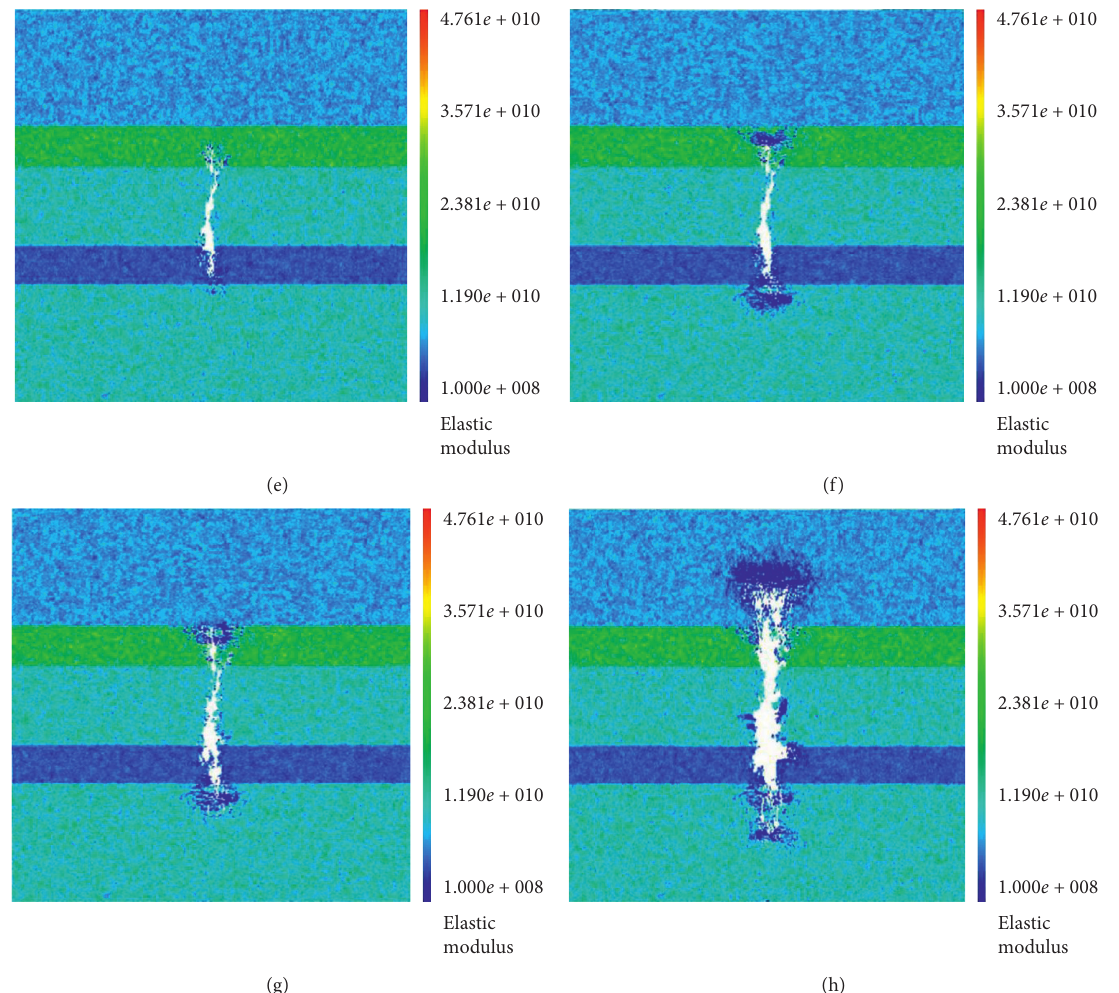
Figure 4: Elasticity modulus evolution of numerical model No.1. (a) Step 29-1. (b) Step 36-1. (c) Step 39-3. (d) Step 39-4. (e) Step 39-7. (f) Step 39-8. (g) Step 39-13. (h) Step